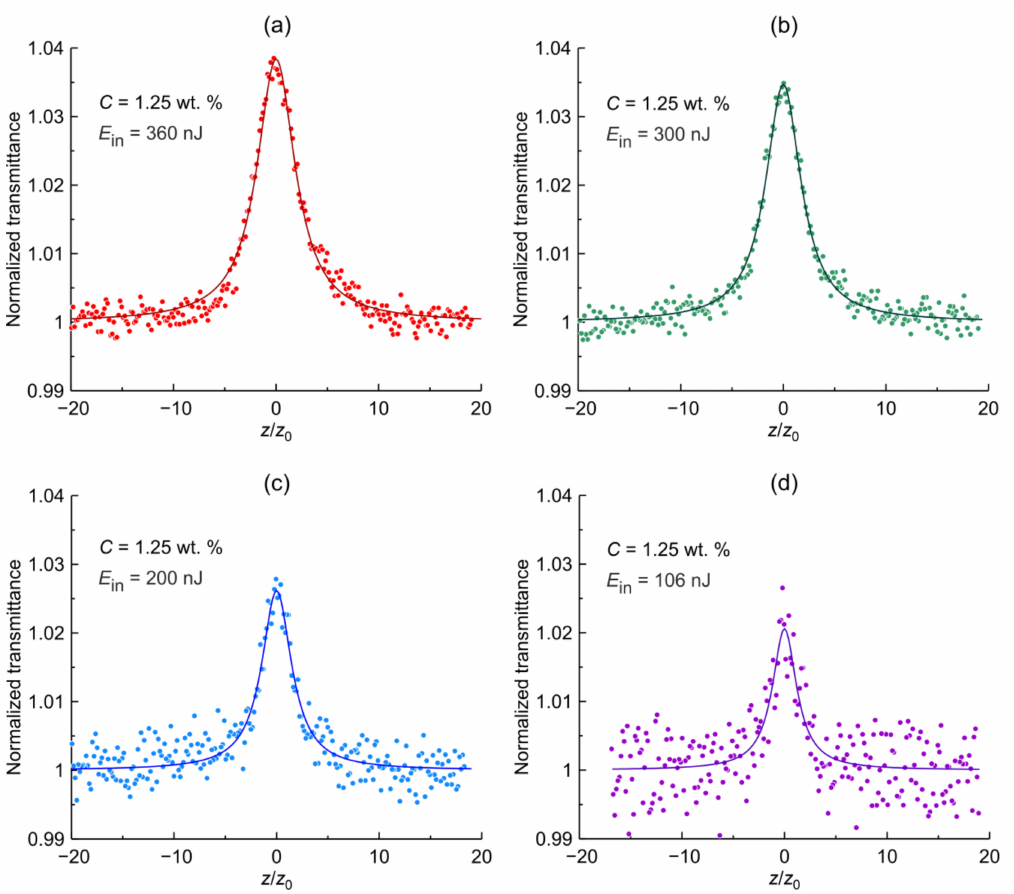
Figure 7. ( a – d ) Normalized transmittance of suspensions of detonation nanodiamonds obtained in the open-aperture z-scan for a fixed concentration of 1.25 wt% for various incident laser pulse energies ranging from 106 to 360 nJ. Dots represent the experimental data while solid lines represent the result of the fitting with Equation